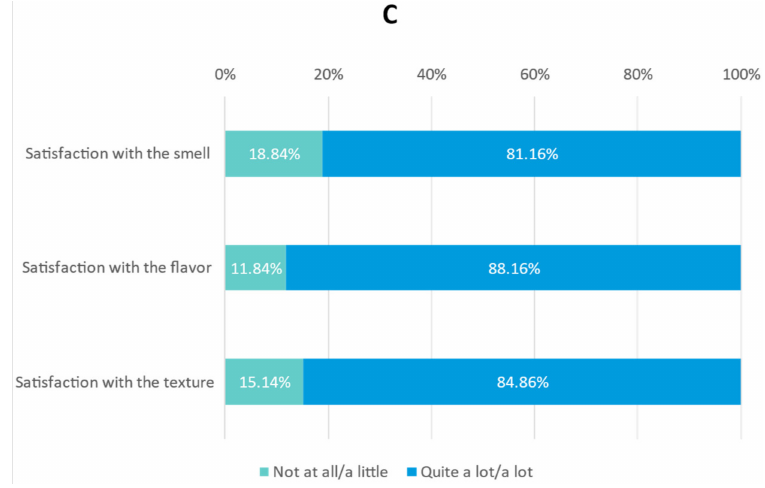
Figure 3. ( A ) Overall patient satisfaction with the ONS received; ( B ) Level of satisfaction with the benefit of the ONS; ( C ) Patient satisfaction with the organoleptic properties.